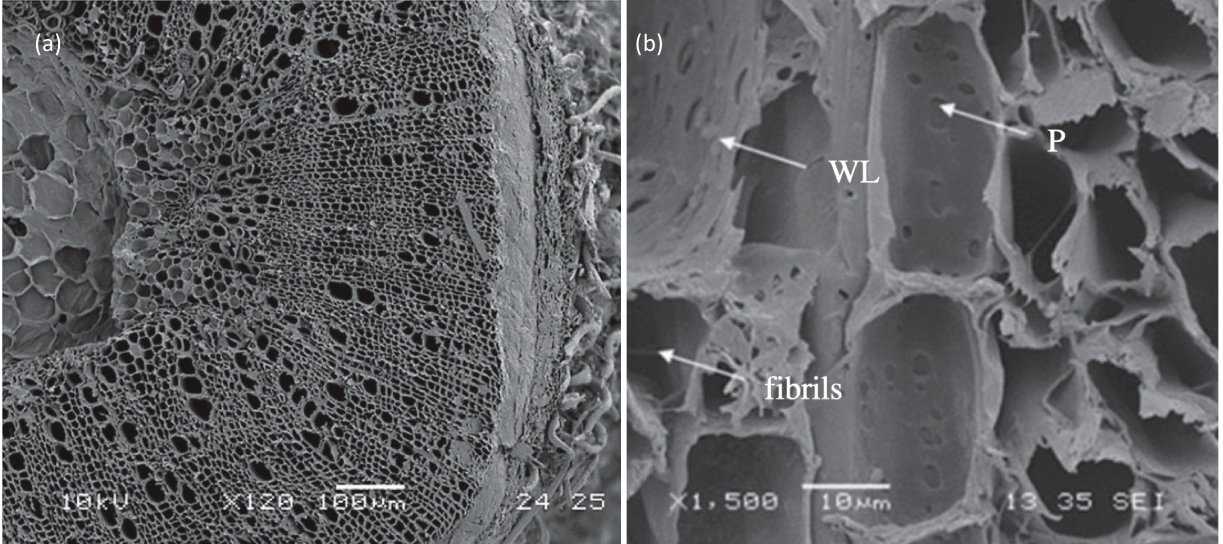
Figure 3. Images of ( a ) cross section of hemp stem and ( b ) the secondary walls of vessels in hemp shiv. WL, warty layer; P, simple pits. (Reproduced with permission from Jiang et al., Royal Society Open Science; published by The Royal Society, 2018. [39] ).